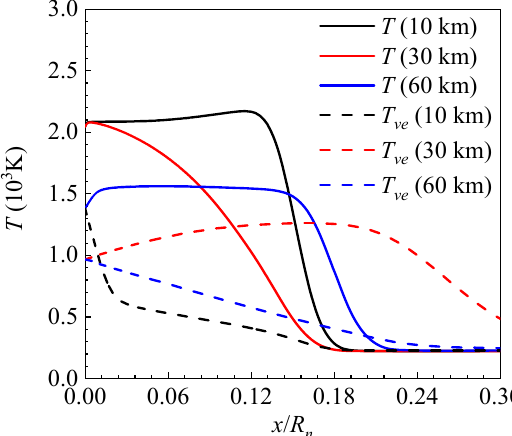
Figure 7. Temperature curves along the stagnation line at α = 60°.